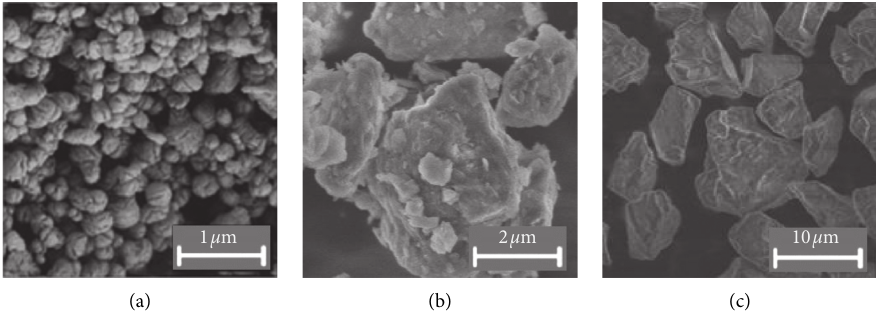
Figure 11: FESEM images of (a) 1 μ m PTFE, (b) A1, and (c) A4 Arizona